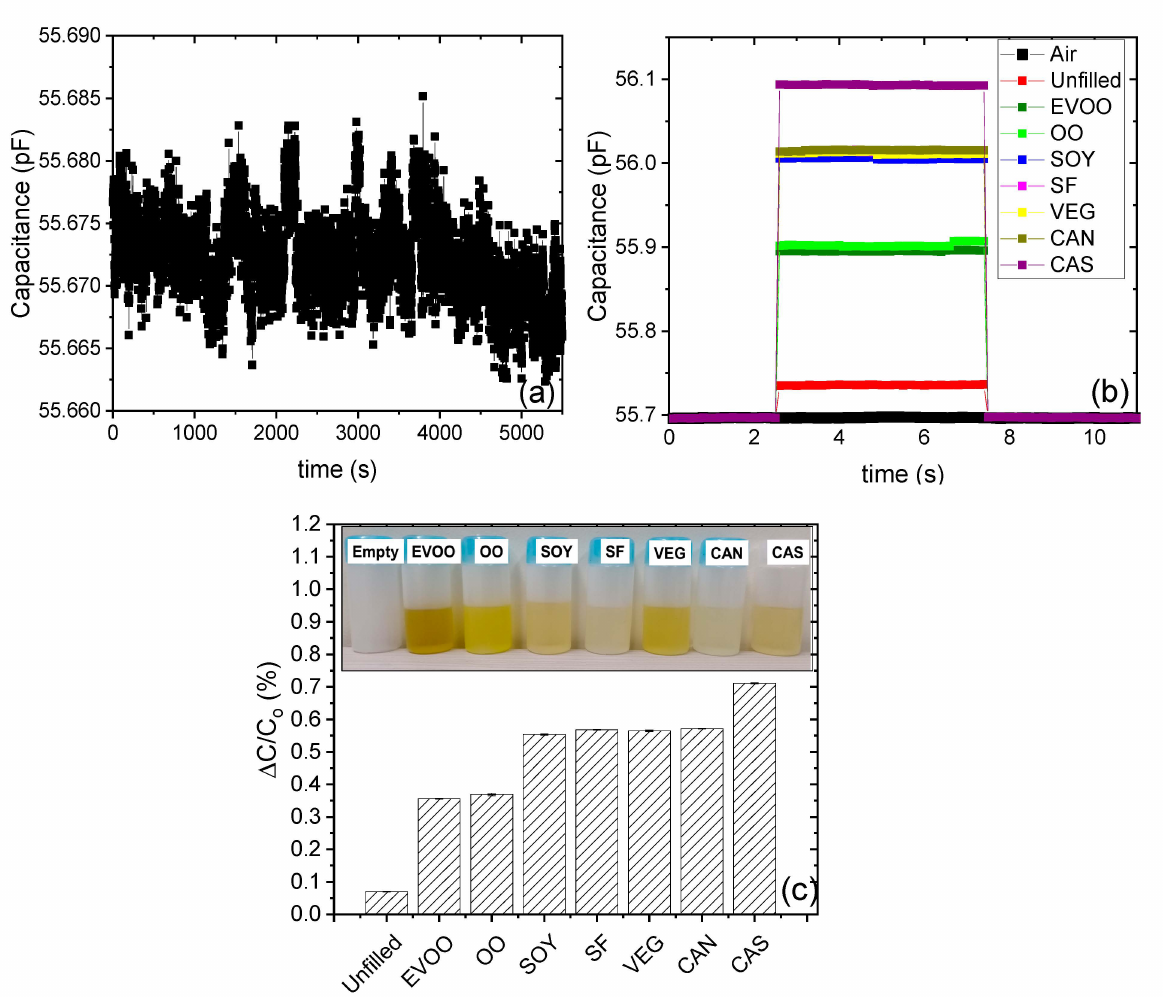
Figure 2. Sensor characterization: ( a ) Real-time capacitance of the sensor (in air) recorded for ~1.5 h. ( b ) Capacitance vs time and ( c ) ∆ C/C 0 ( ± σ ) of unfilled containers and unblended oil-filled containers, respectively, expressed in percentage. Extra virgin olive oil − EVOO, olive oil − OO, soybean oil − SOY, sunflower oil − SF, vegetable oil − VEG, canola oil − CAN and castor oil −